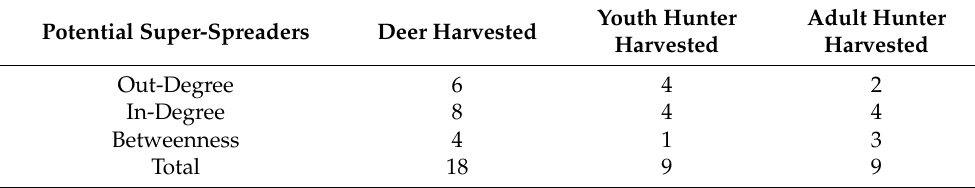
Table 4. Hunter Harvested Potential Super-Spreaders. The table displays the number of high-ranking out-degree, in-degree, and betweenness potential super-spreaders within the region-wide network harvested by hunters. Also shown is the number of potential super-spreaders harvested by youth and adult hunters.